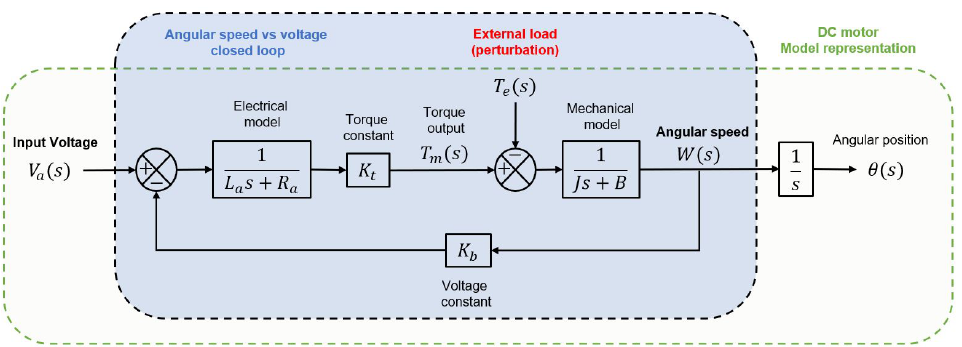
Figure 2. The DC motor block diagram represents the electrical and mechanical components of the device. The electrical component is related to the mechanical component through the torque constant K t . The angular speed and voltage input are related through the Back EMF constant K b